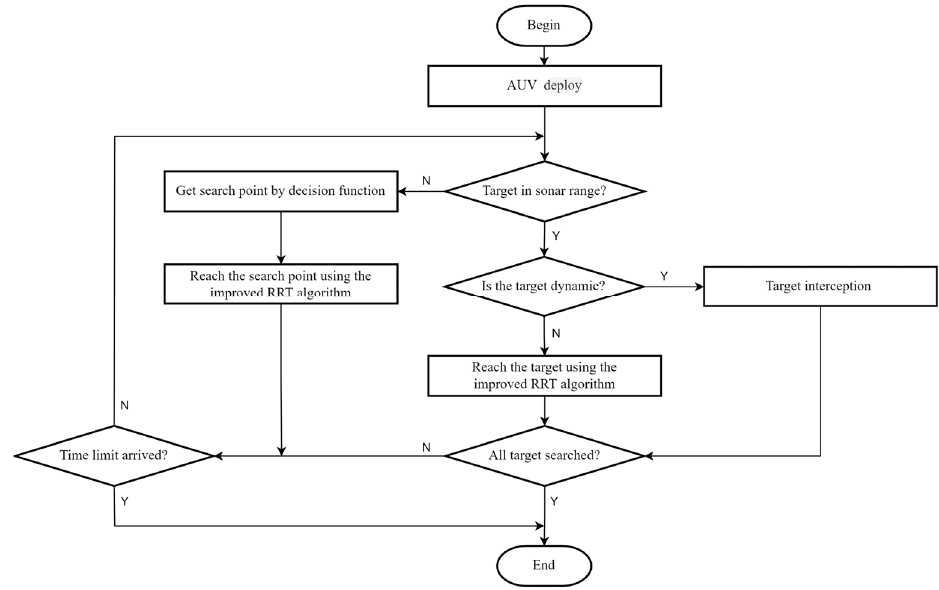
Figure 1. Search process flowchart.